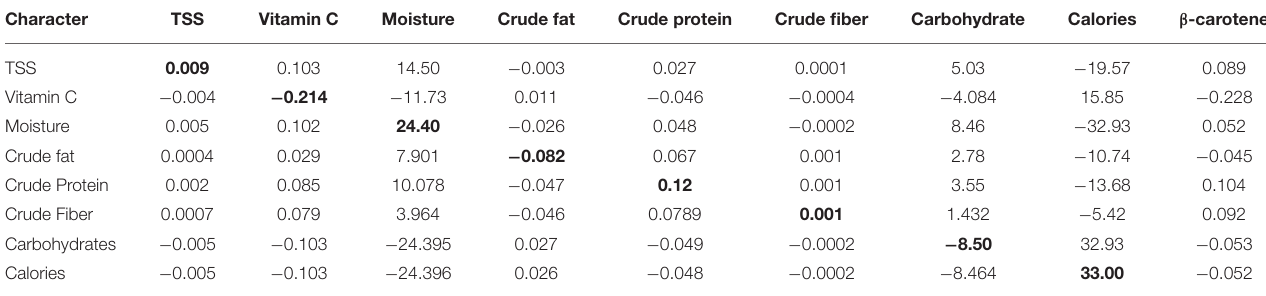
TABLE 2 | Estimation of direct and (bold numbers) indirect effects of nutritional parameters of 64 Daucus carota L. genotypes on β -carotene content.